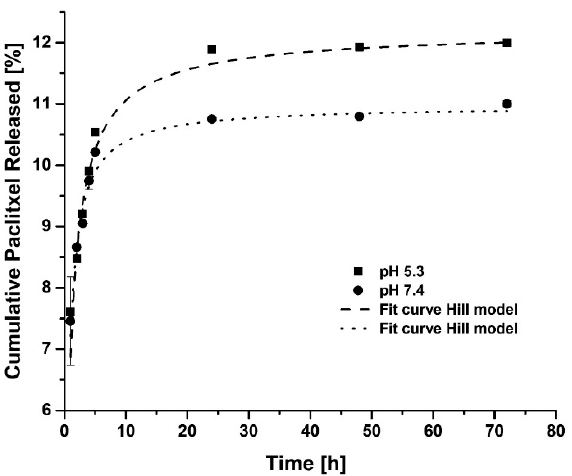
Figure 4. In vitro release profile of Paclitaxel from DOTA-DN(PTX)-BN system at pH 5.3 and 7.4 (mean ± SD, n = 3).